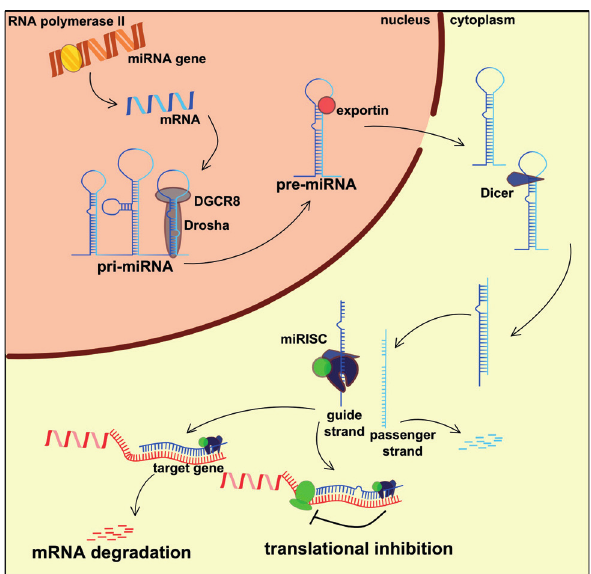
Fig. 1. MiRNA biogenesis. miRNA genes are transcribed in the nucleus, into long primary precursors – pri-miRNAs. Then, they are cleaved by Drosha and Pasha. Secondary precursors are short, stem-loop structures, known as pre-miRNAs that are further actively transported to cytoplasm by exportins. In the cytoplasm, pre-miRNAs are processed near the terminal loop by RNase III type endonuclease Dicer, and this generates mature miRNA/miRNA* duplexes.